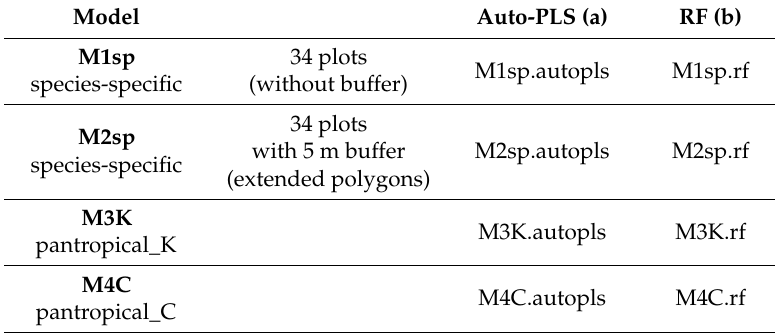
Table 4. Designation of the regression models tested for predicting biomass on a plot level from the lidar statistics. Model 1 species-specific (M1sp), Model 2 species-specific (M2sp), Model 3 pantropical_K (M3K), and Model 4 pantropical_C (M4C) using 34 plots for ( a ) Auto-PLS, ( b ) and random forest